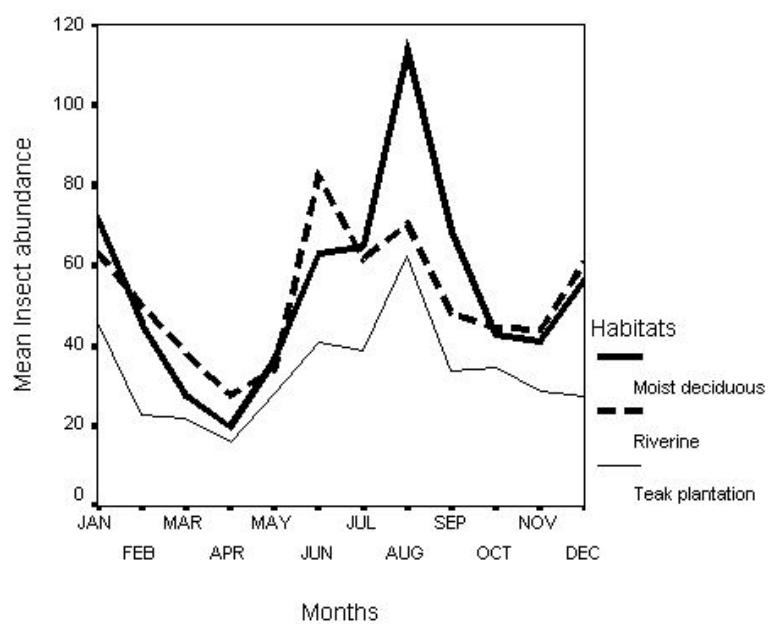
FIGURE 3. Pattern of fluctuation in the insect abundance in different